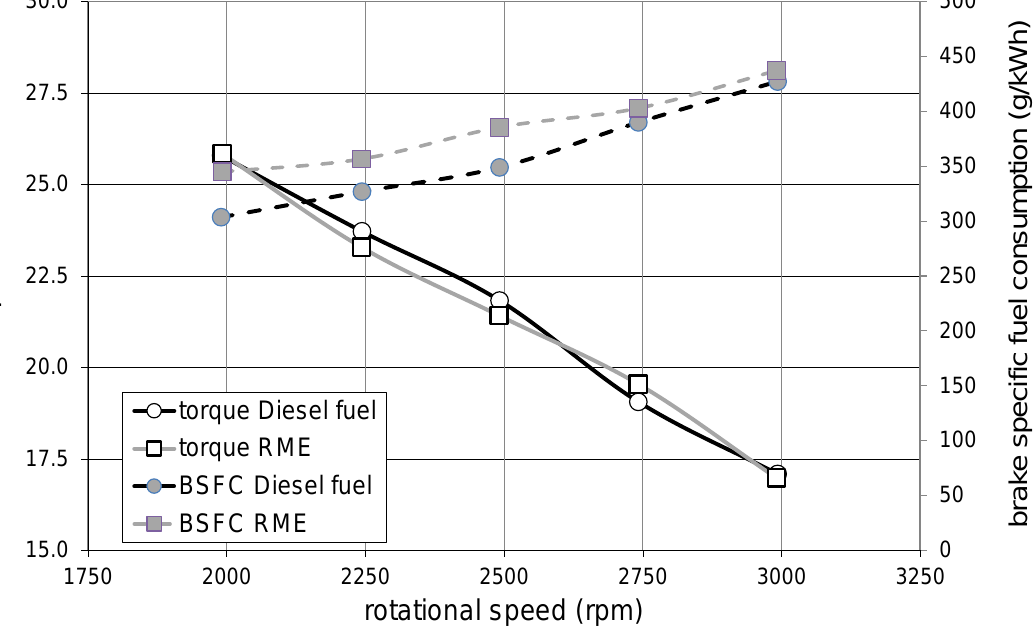
Figure 3. Fuel mass flow rate and injected mass per cycle as a function of the engine rotational speed for the two tested fuels.